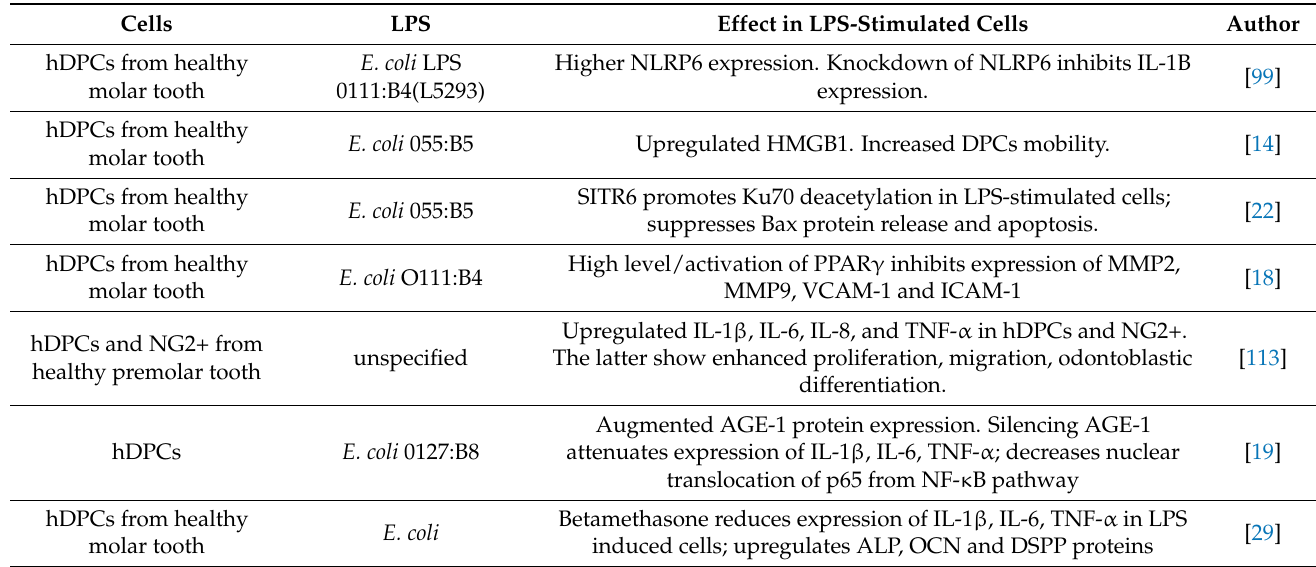
Table 1. Table summarize type of cells, origin of LPS and effects of LPS stimulation of selected